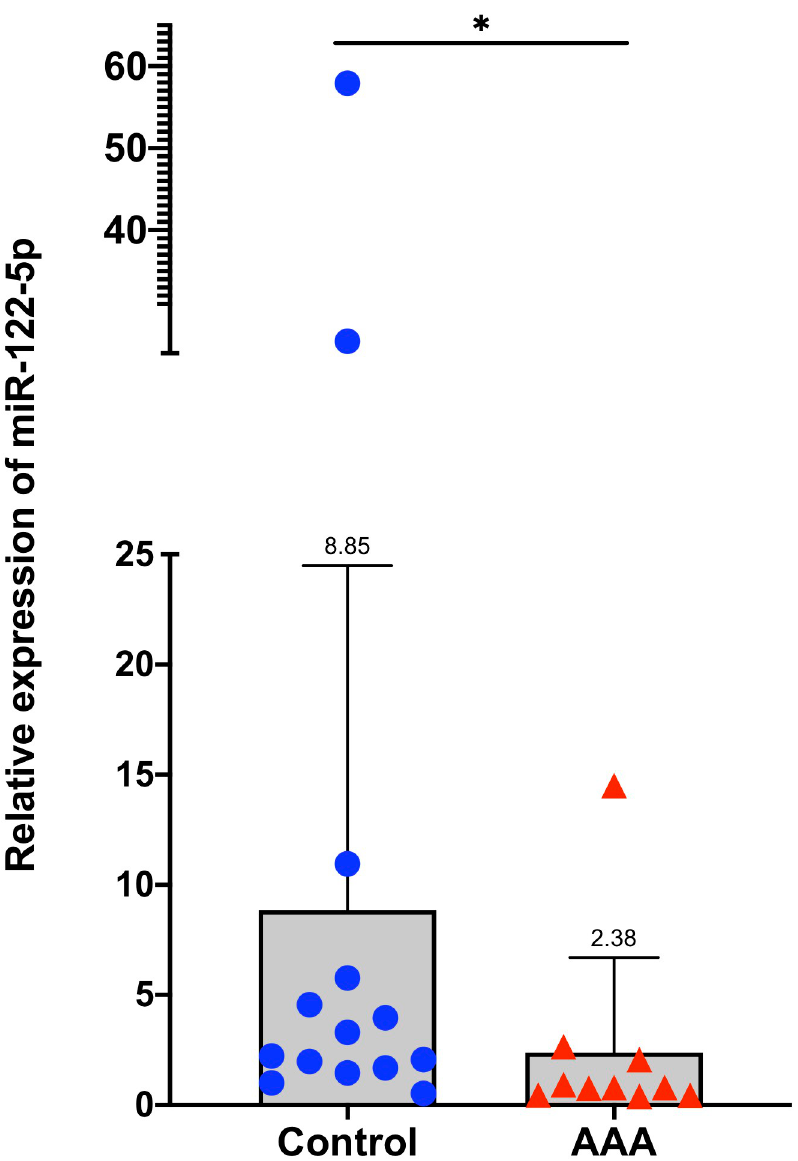
Fig 4. qRT-PCR analysis of miR-122-5p. MicroRNA levels are presented as fold changes (2- ΔΔ Ct). The Y-axis depicts values normalized to miR-16-5p. The mean relative expression of exosomal miR-122-5p was 2.38 vs. 8.85 in the AAA and control group, respectively ( P = 0.026). � P < 0.05. AAA, abdominal aortic